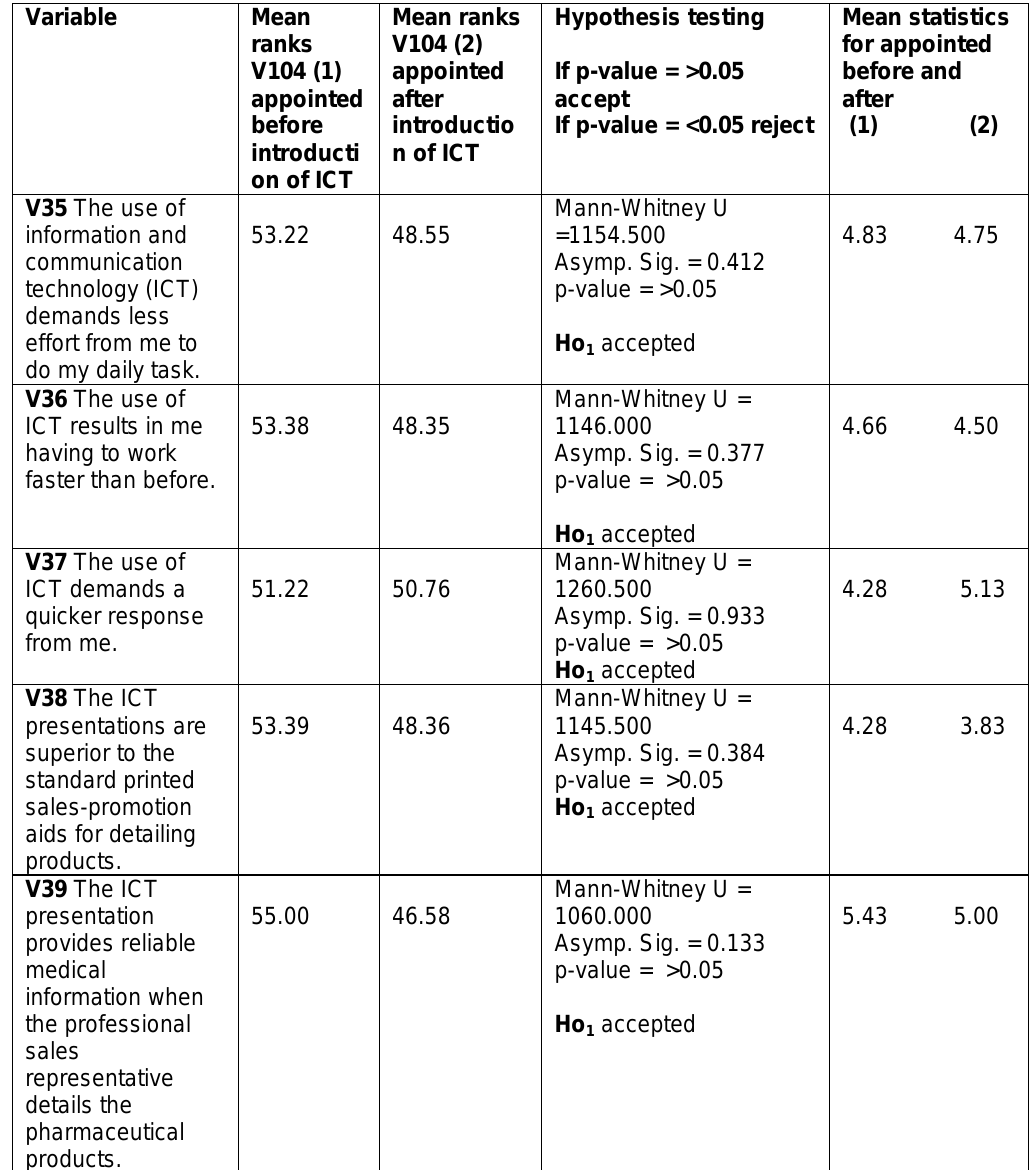
Table 1: The influence of ICT on sales